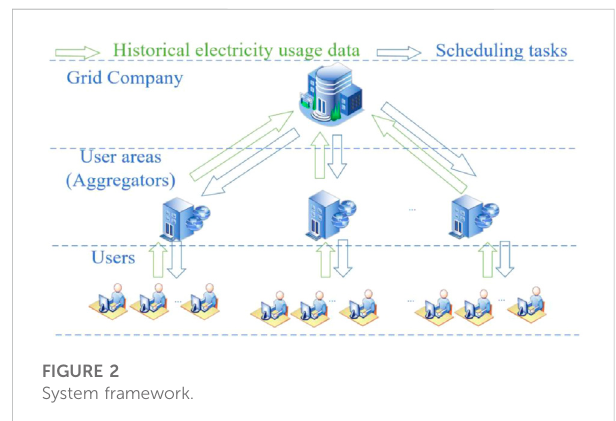
FIGURE 2 System